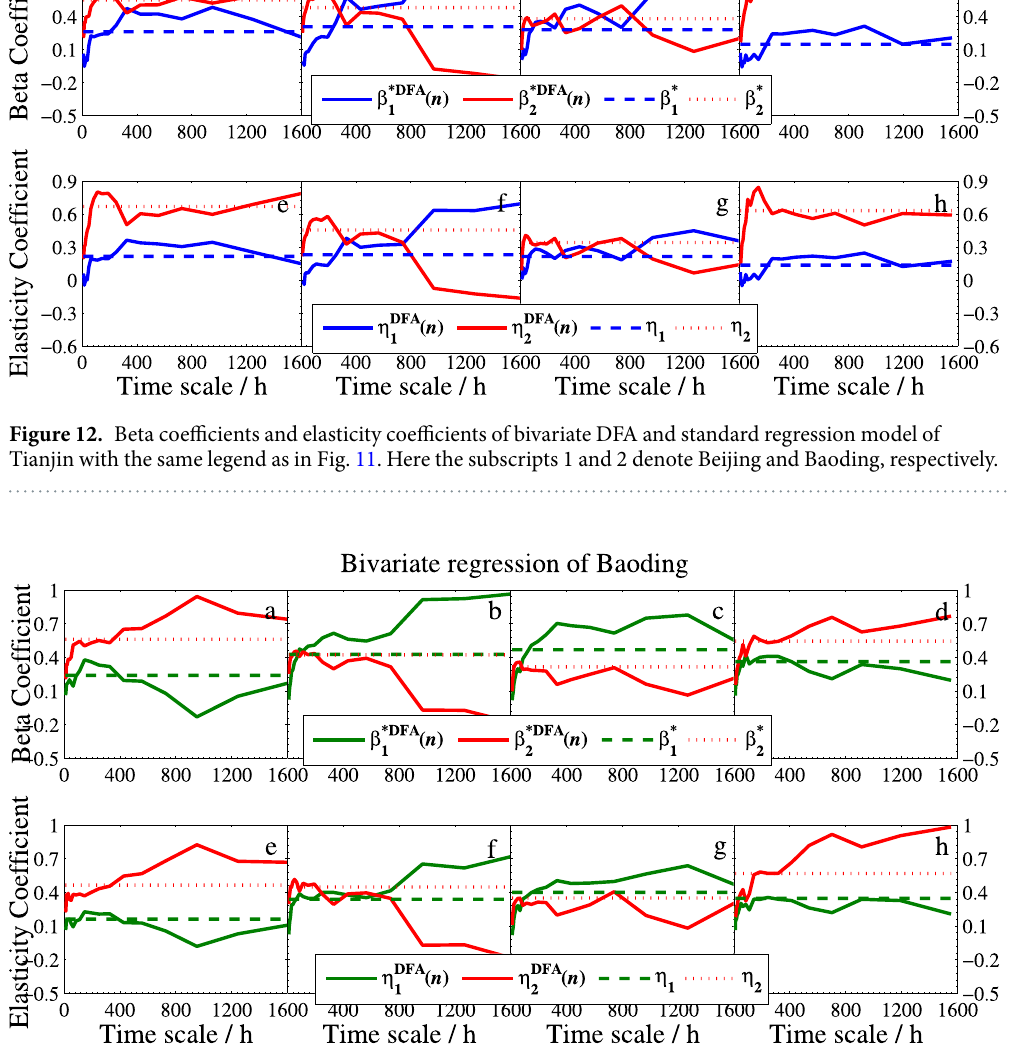
Figure 13. Beta coefficients and elasticity coefficients of bivariate DFA and standard regression model of Baoding with the same legend as in Fig. 11. Here the subscripts 1 and 2 denote Beijing and Tianjin,